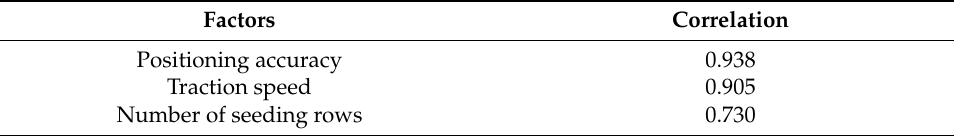
Table 4. Analysis on Correlation with Seeding